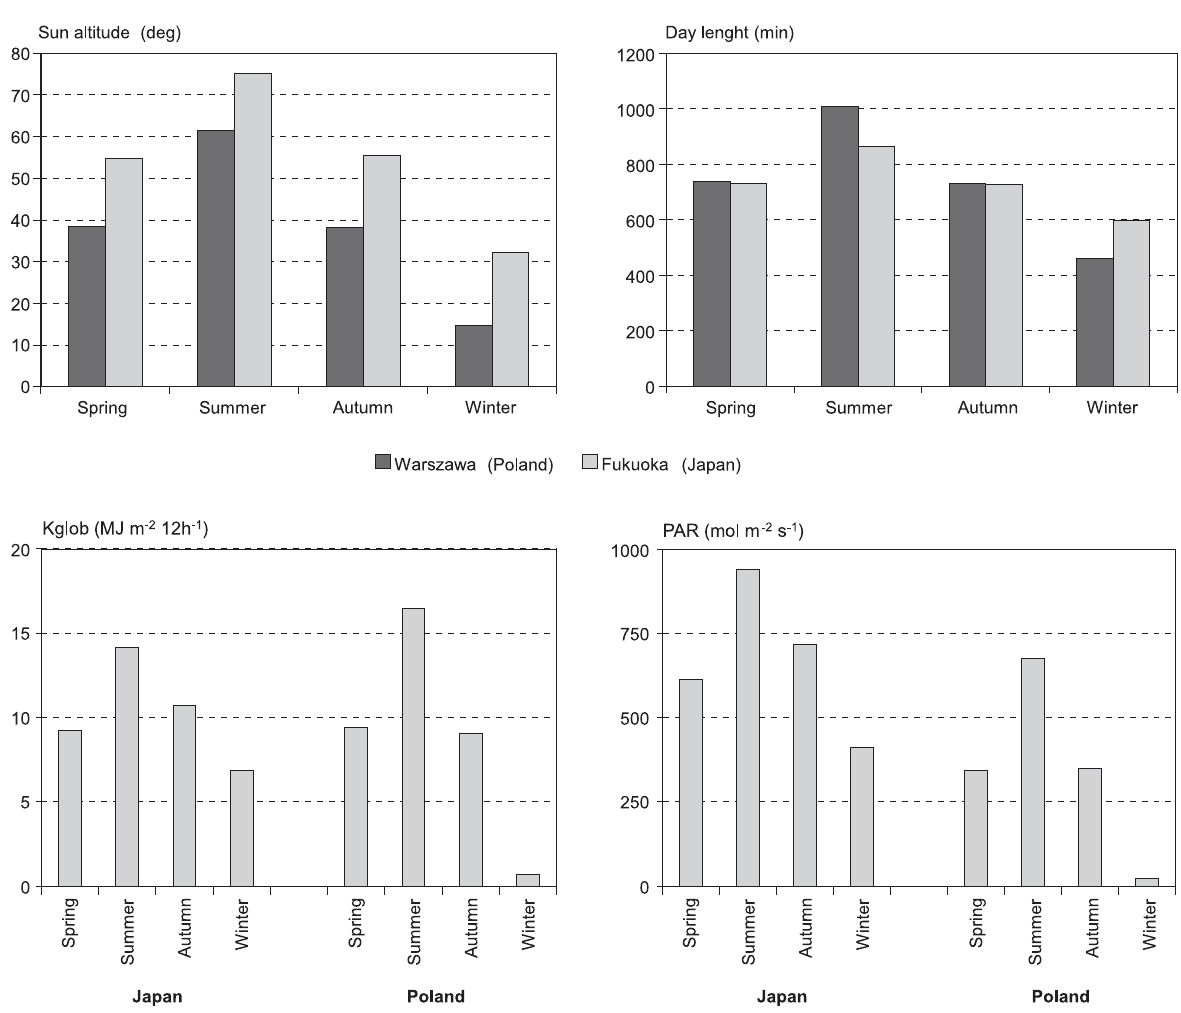
Fig. 1. Seasonal values of particular environmental parameters: day length, midday Sun altitude, daytime totals of global solar radiation (Kglob) and mean daytime values of photosynthetically active radiation (PAR) in Fukuoka (Japan)